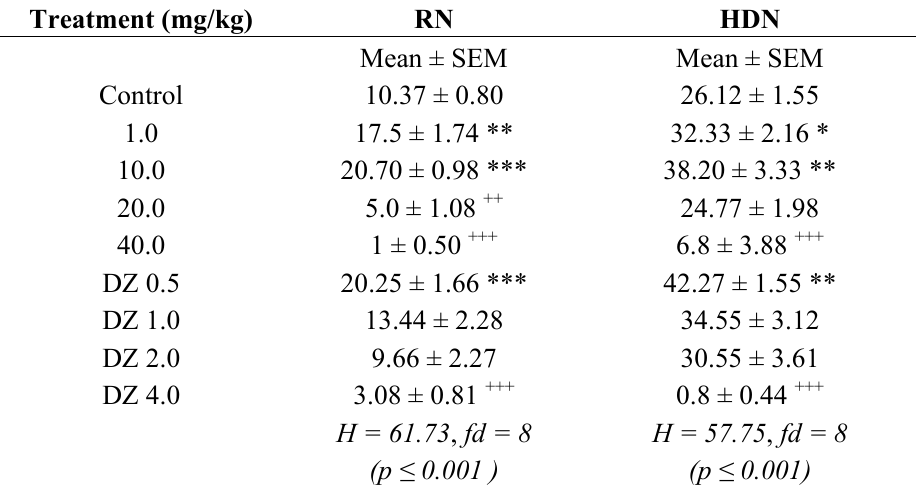
Table 1. Effect of NEO on the performance of mice in the hole-board